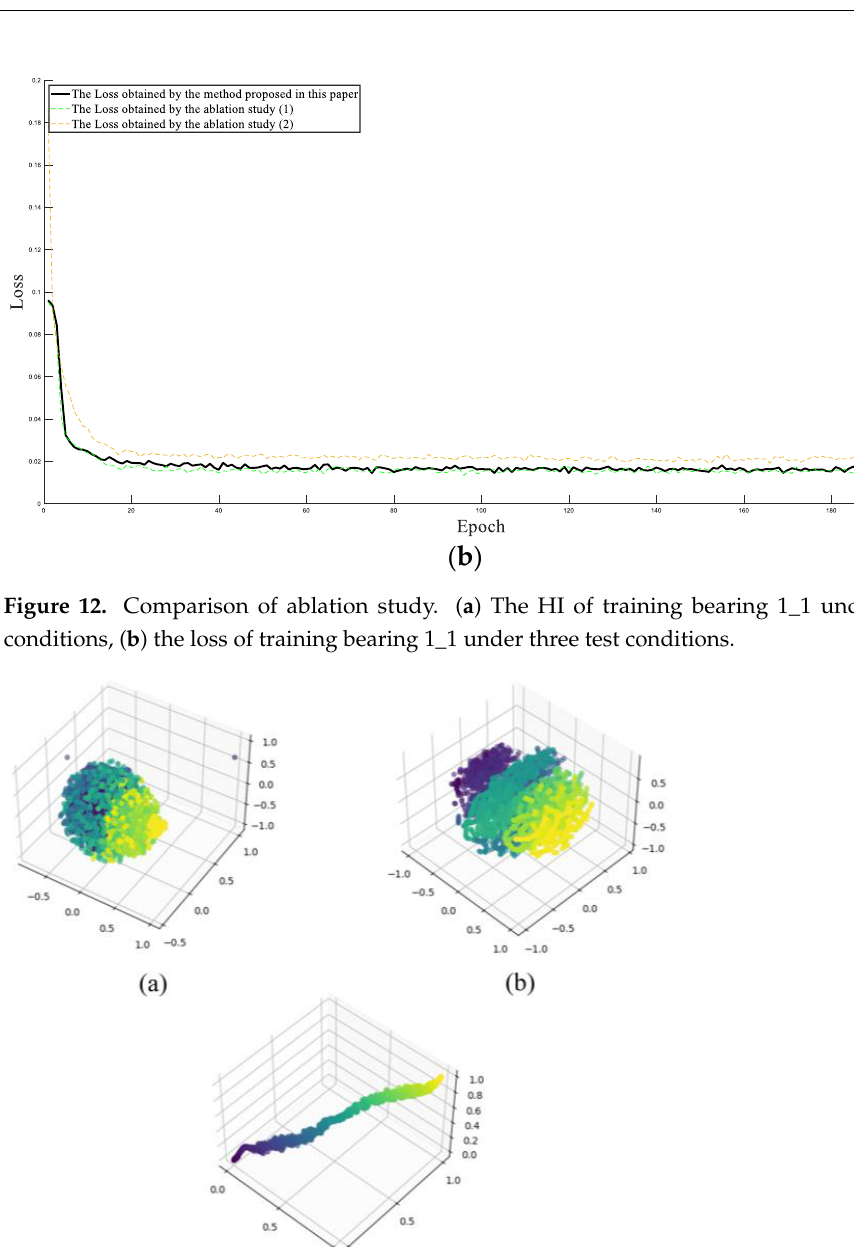
Figure 13. Hidden layer features displayed by t-SNE. ( a ) Input layer, ( b ) the first maxpooling layer, ( c ) the first fully connected layer